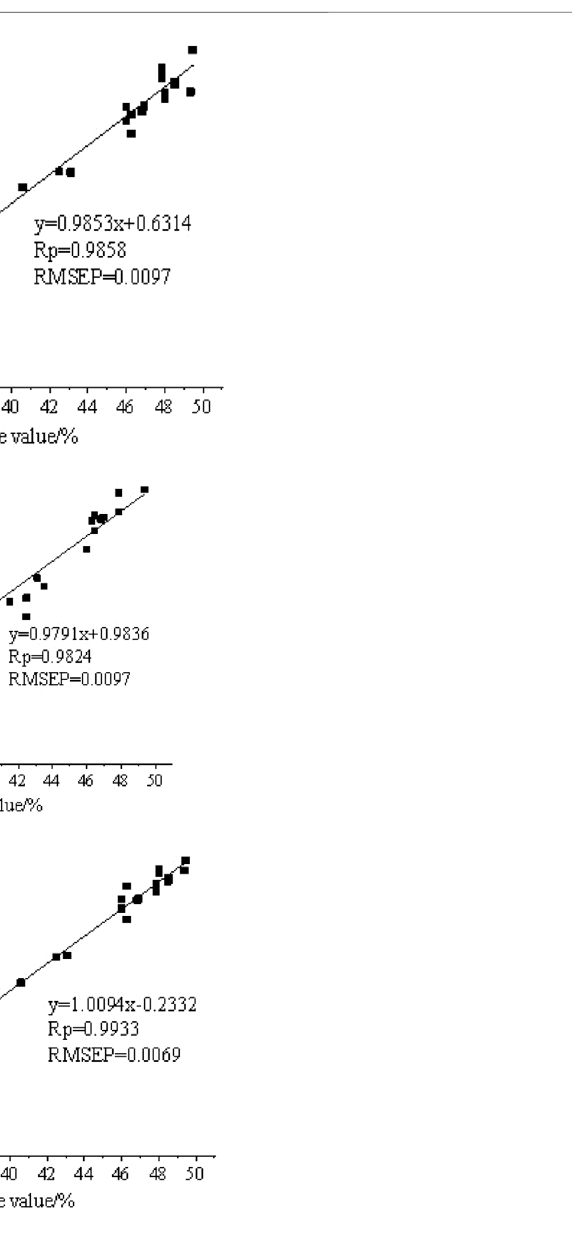
FIGURE 13 | (A) THz characteristic variable fi tting; (B) NIR characteristic variable fi tting; (C) THz NIR characteristic variable fi